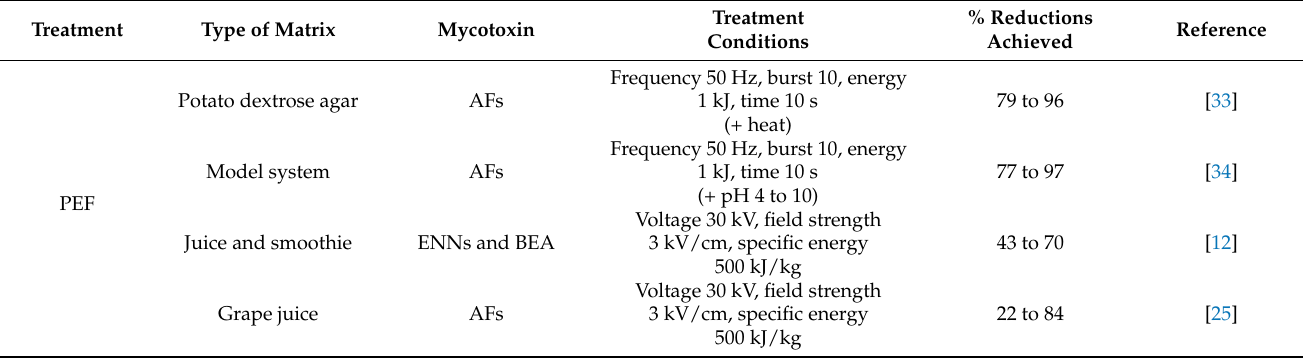
Table 4. Summary of literature available on the reduction percentages of mycotoxins in food products after the emerging